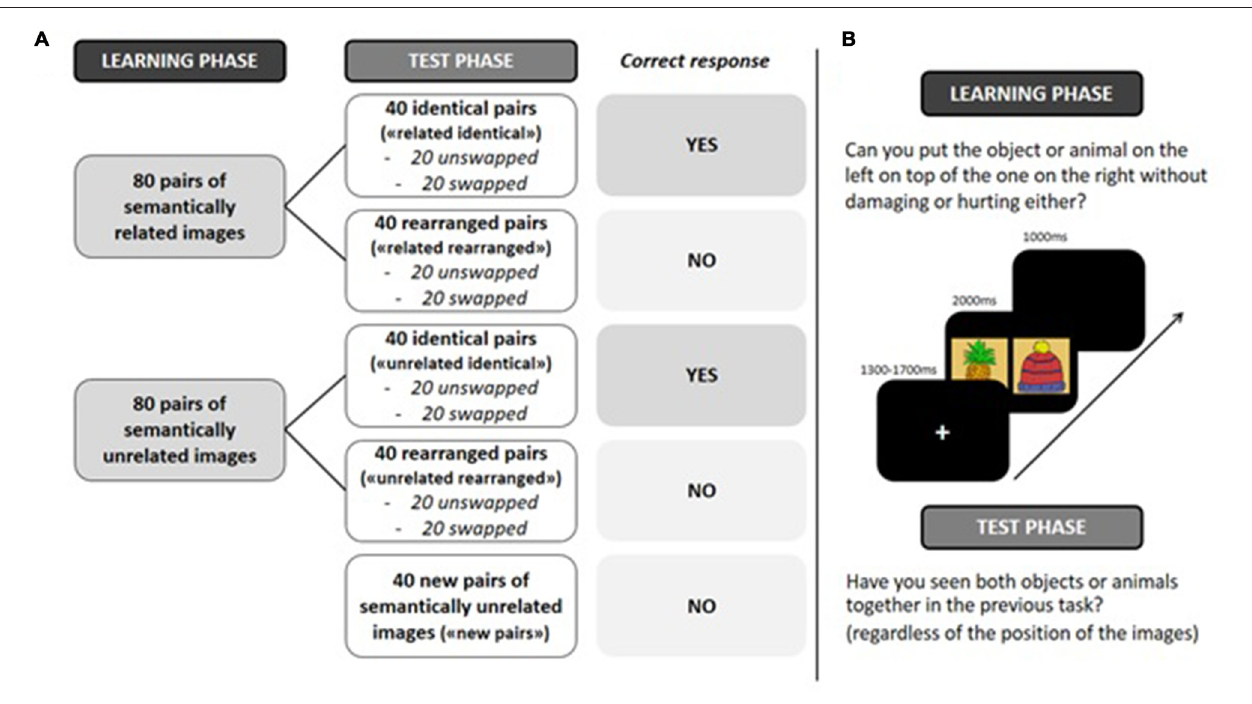
FIGURE 2 | (A) Experimental design. (B) Experimental procedure. “related identical”: semantically related identical pairs; “related rearranged”: semantically related rearranged pairs; “unrelated identical”: semantically unrelated identical pairs; “unrelated rearranged”: semantically unrelated rearranged pairs; “new pairs”: semantically unrelated new